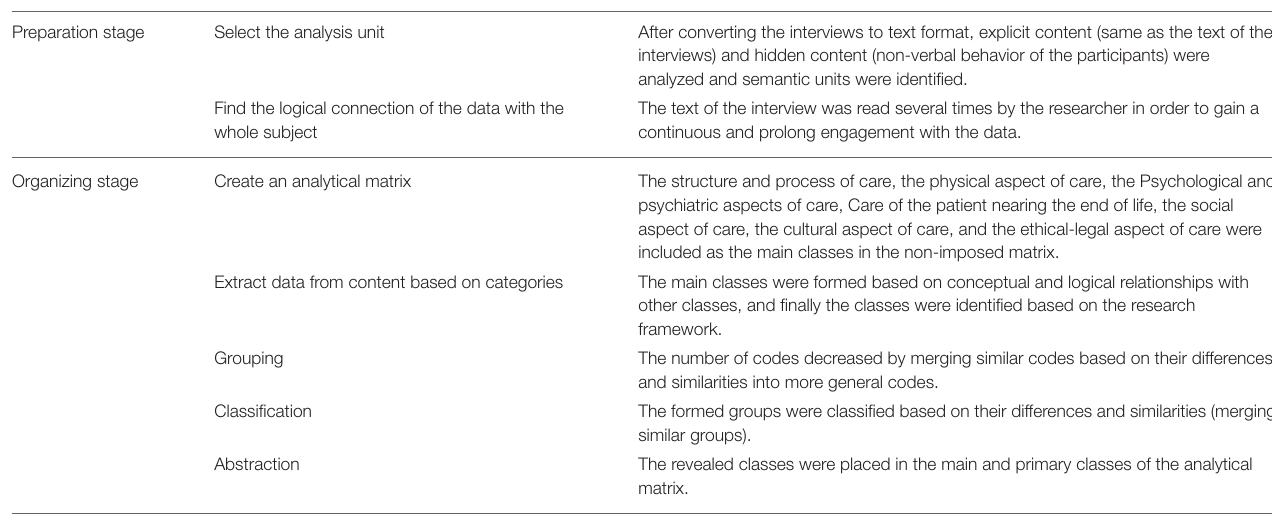
TABLE 2 | Qualitative data analysis process based on Elo Kyngas method. Preparation